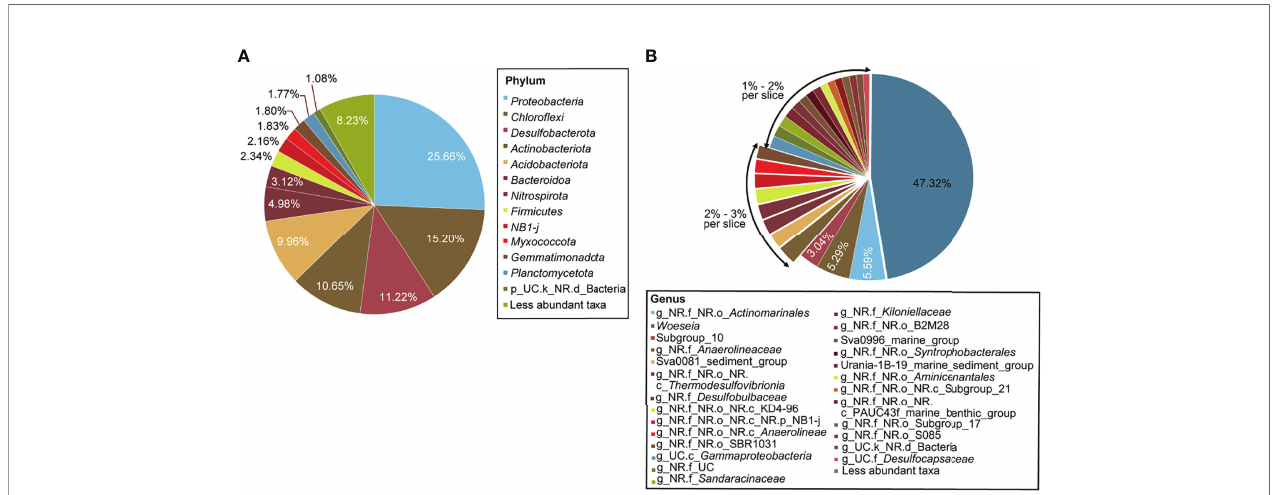
FIGURE 2 | Pie charts of bacterial community compositions of 42 sites classi fi ed at the phylum (A) and the genera level (B) . Only taxa with relative abundances more than 1% are shown and taxa at less than 1% are represented as less abundant taxa. k, kingdom; p, phylum; c, class; o, order; f, family; g, genus; NR, norank; UC, unclassi fi